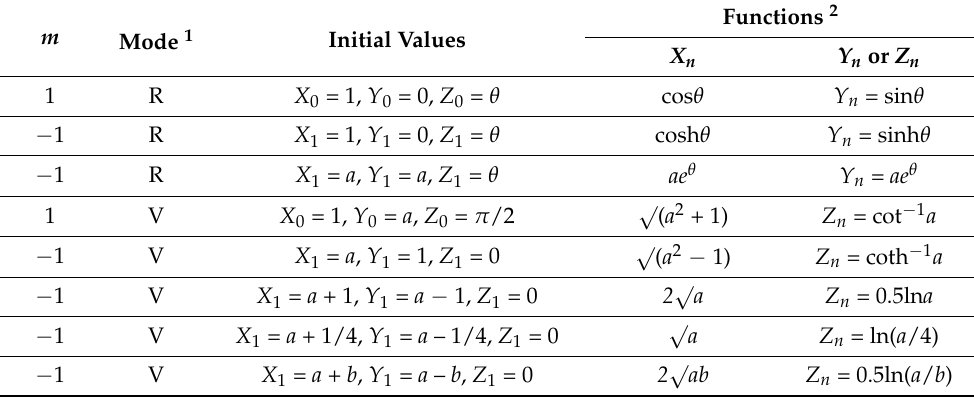
Table 1. Functions with CORDIC